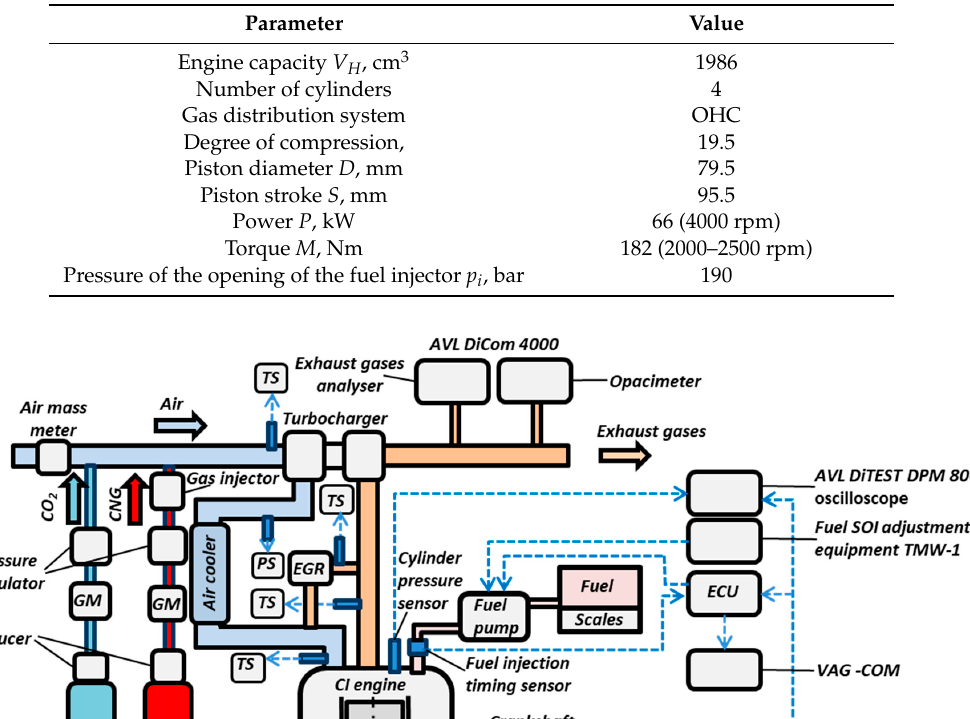
Table 2. Key parameters of the1.9 TDI (1Z) compression ignition engine.